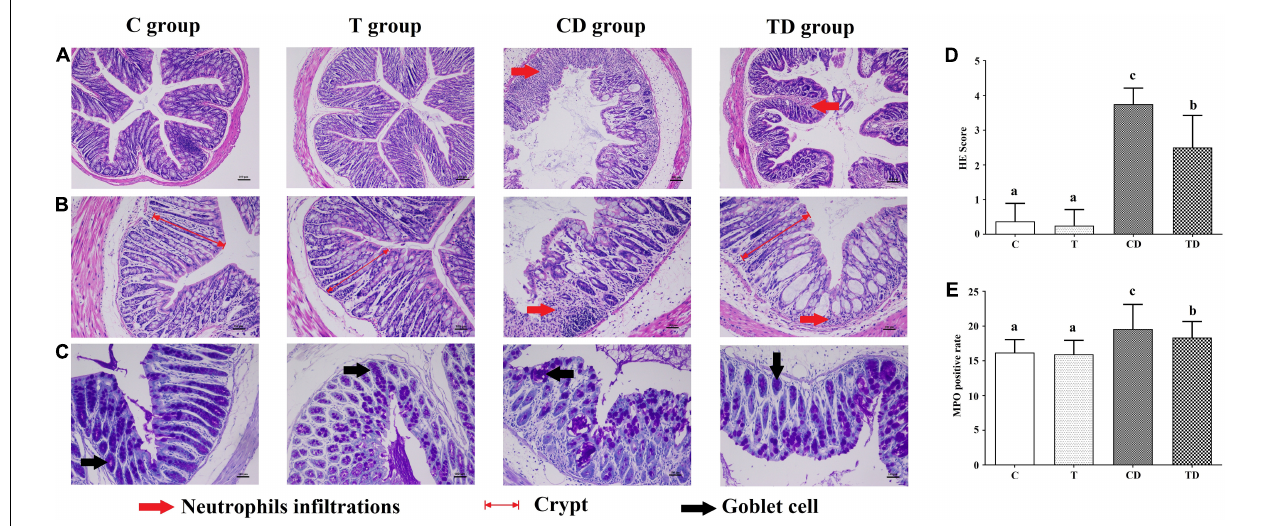
FIGURE 2 | Histopathological analysis of colon segments. (A,B) Staining of colon tissues of mice with hematoxylin–eosin (H&E), original magnifications of × 100 (A) and × 200 (B) . (C) Goblet cells observed with Alcian blue/periodic acid–Schiff (AB/PAS) staining. (D) Determination of the histological scores for the control (C), dextran sodium sulfate (DSS) model (CD), and Tibetan tea + DSS (TD) groups. (E) Sections immunostained with mouse anti-myeloperoxidase (MPO) antibody in each group, with the positive cells staining brown. The positive rate of MPO cells (the number of positive cells/total cell number × 100) was calculated using HALO. Lowercase letters a – c indicate significant differences in all treatment groups ( p <